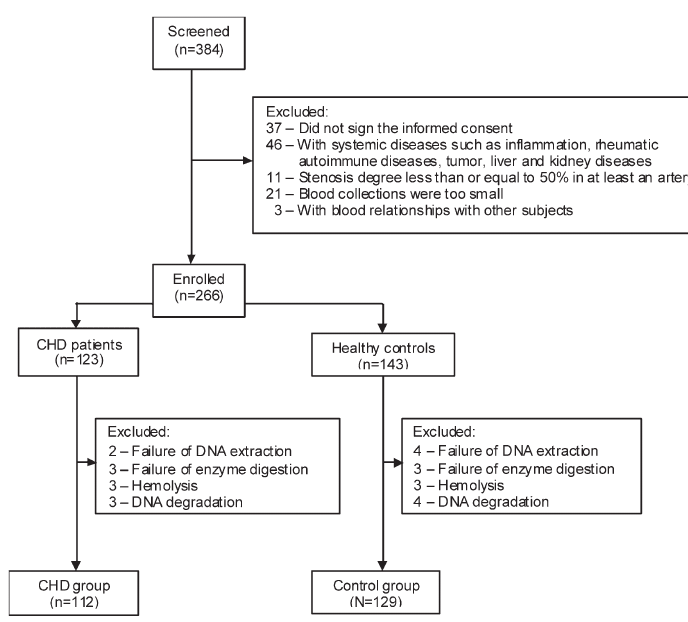
Figure 1. Flow chart of the